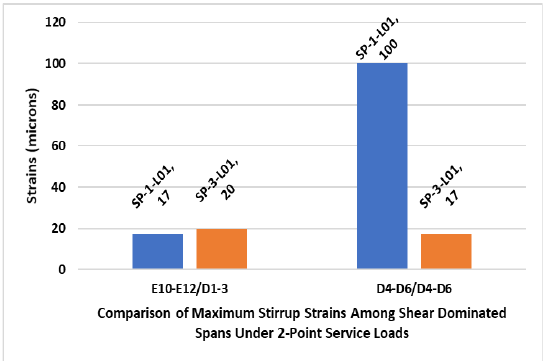
Figure 33. Comparison of maximum stirrup strains recorded for loading setup SP-1-L01 and SP-3-L01 under two-point service loads.